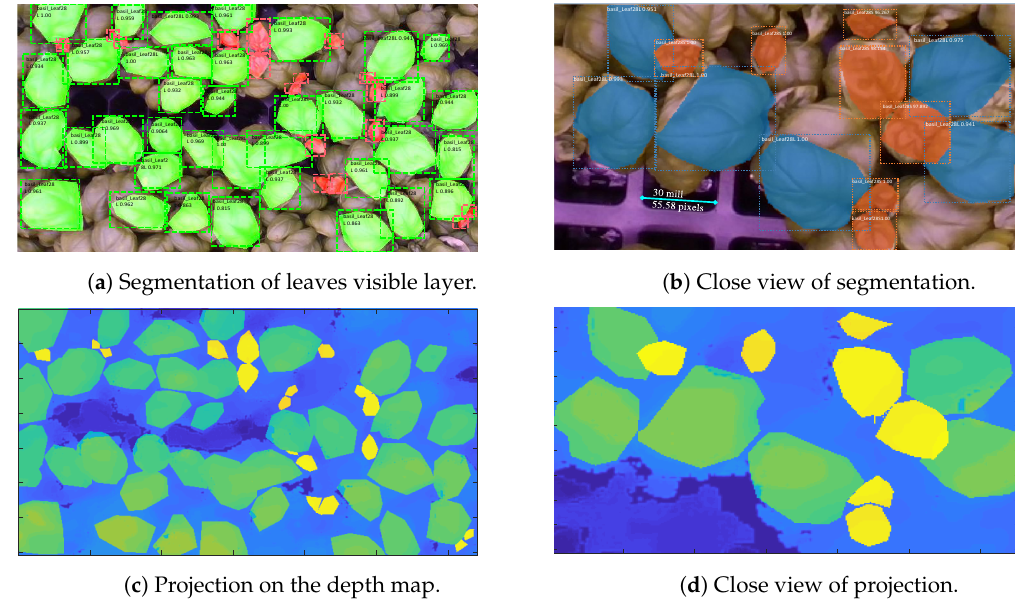
( c ) Projection on the depth map. ( d ) Close view of projection. Figure 6. Segmentation of large and new leaves and projection of the segmentation on the depth